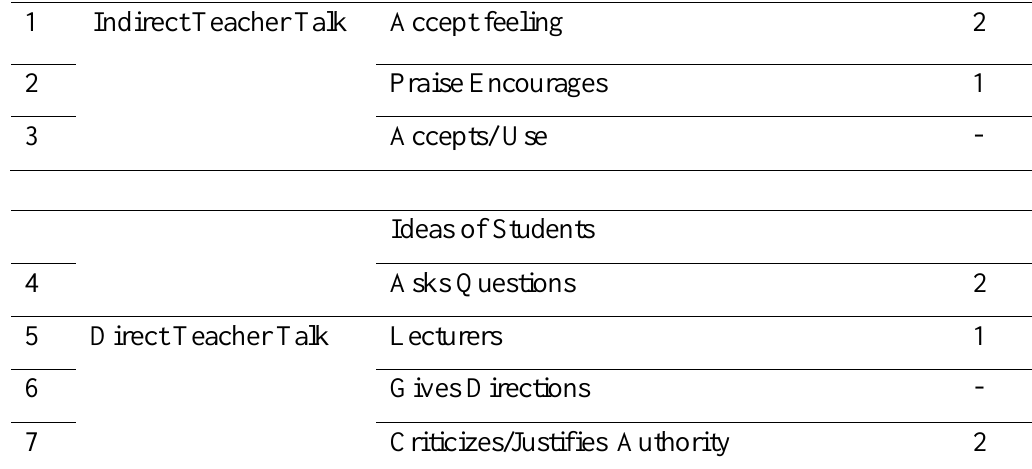
TABLE 2 . The Result of Observations of Researchers and Teachers for Students No